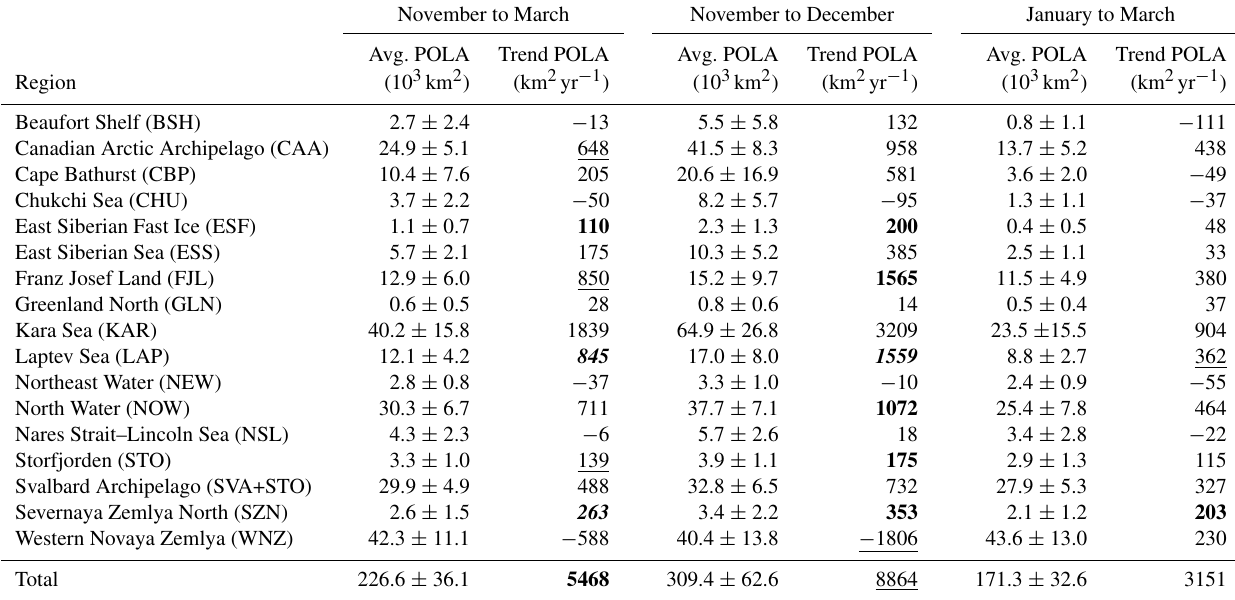
Table 2. Average polynya area (POLA) in km 2 in each polynya region between 2002/2003 and 2014/2015 (SFR cloud-cover correction applied). Aside from being based on the available winter period from November to March, it is further separated between the early freezing season (November to December) and the late freezing season (January to March). All values are derived from daily MODIS TIT composites after application of the predefined polynya masks (Fig. 1). Trends are additionally given, where underlined, bold and bold italic numbers denote statistical significance (two-sided t test) at the 90, 95 and 99% levels,